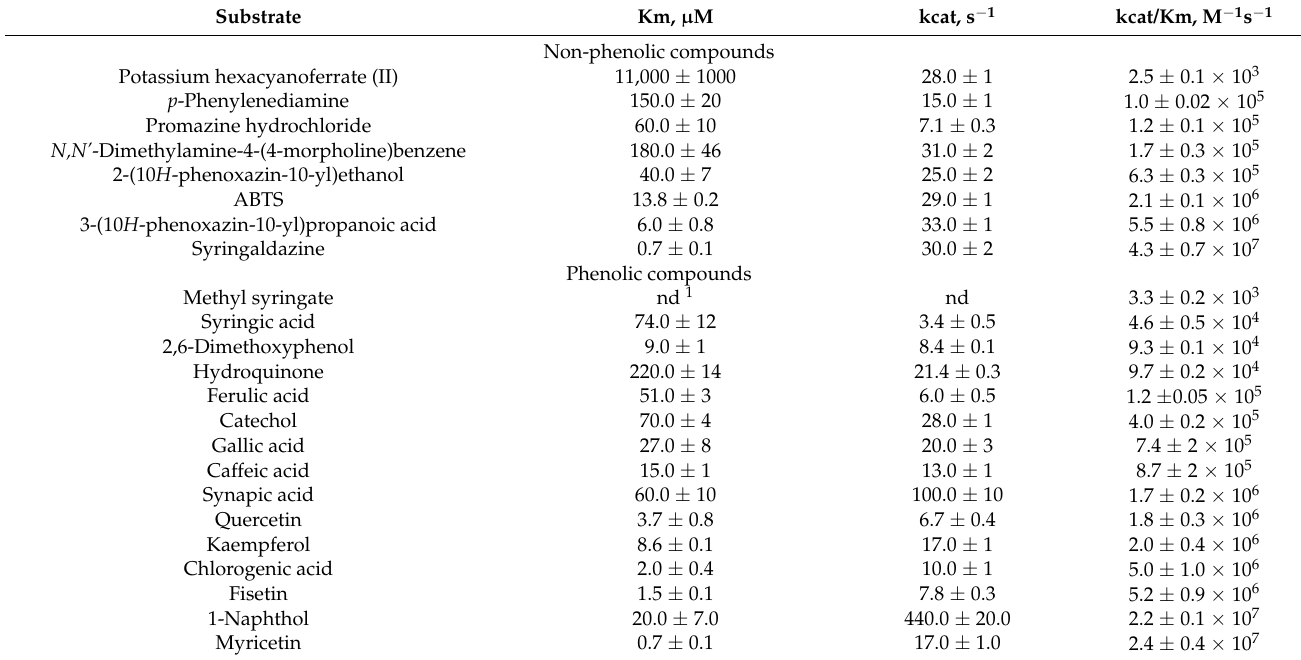
Table 1. Kinetic parameters of the purified laccase Bcl1.